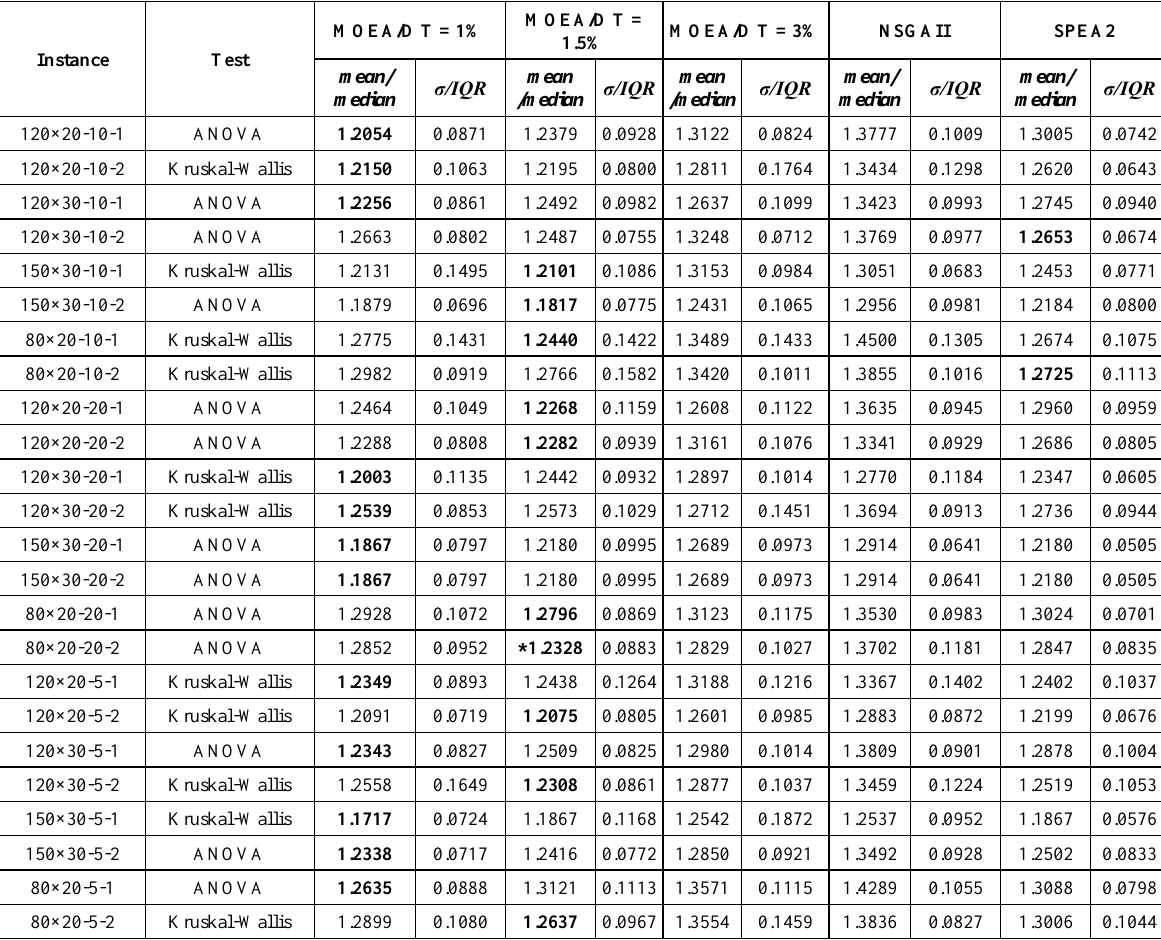
Table 7. Spread comparison with baseline NSGAII and SPEA2.